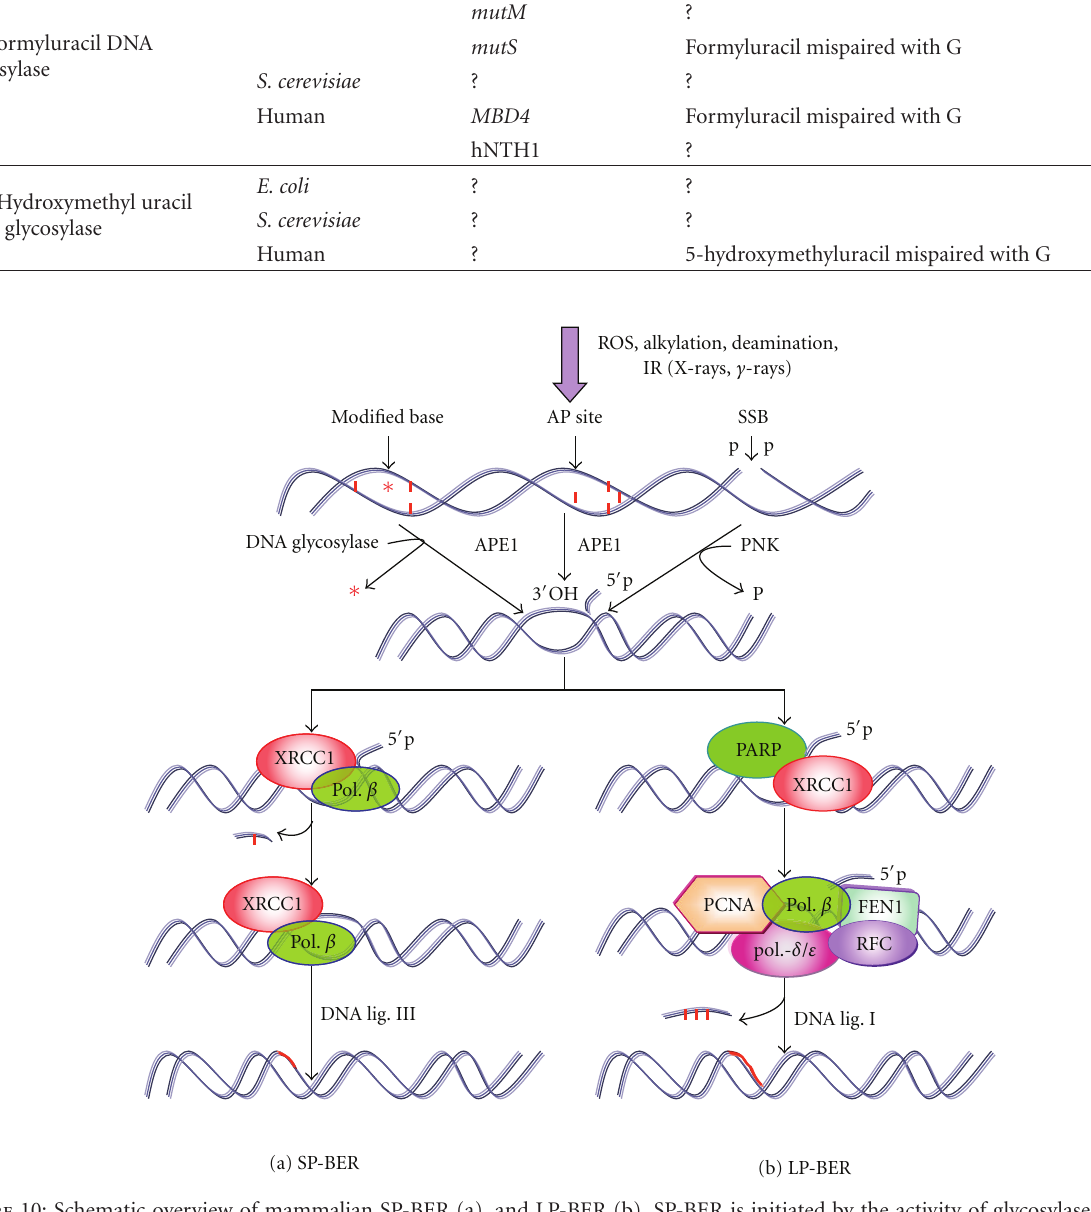
Figure 10: Schematic overview of mammalian SP-BER (a), and LP-BER (b). SP-BER is initiated by the activity of glycosylase and APE1, followed by sca ff old protein XRCC1 and pol. β to remove the damaged nucleotide and DNA ligase III seals the nick. In case of LP-BER, after DNA damage by ionizing radiation, PNK is recruited to convert the damaged ends to 3 (cid:3) OH and 5 (cid:3) P moieties. Here PARP1/2, followed by XRCC1, is involved. PCNA and DNA pol. β and/or pol. − δ / ε extend and fill the gap by > 2 nucleotides. Replication factor-C (RFC) is required to load the PCNA on DNA. Ultimately the resulting 5 (cid:3) flap of DNA is removed by the flap endonuclease I (FEN1) and subsequently the nick is sealed by DNA ligase